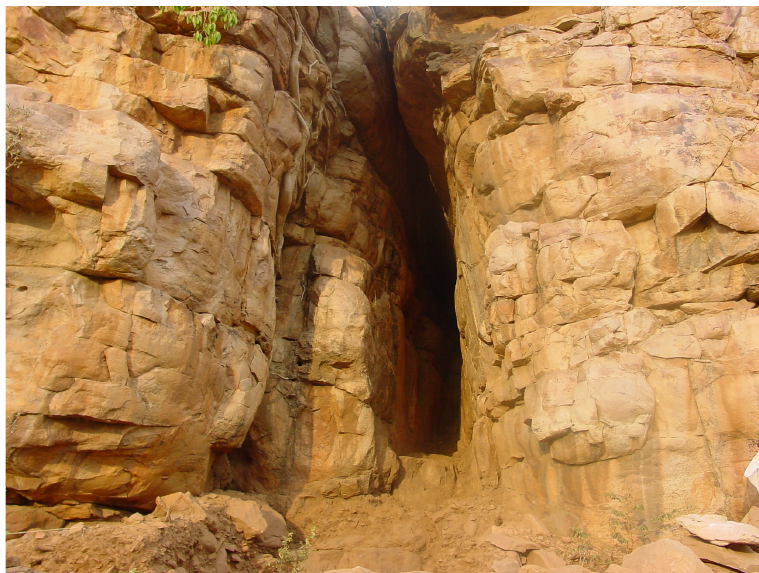
Figure 2. Daraki-Chattan cave (DC) from the front.